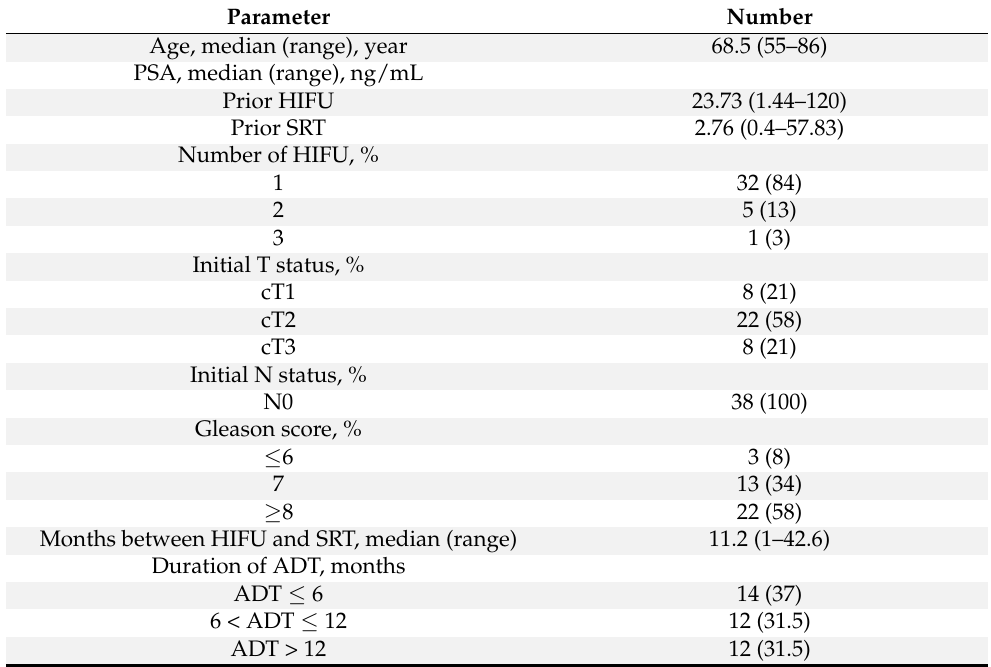
Table 1. Patient characteristics (n =